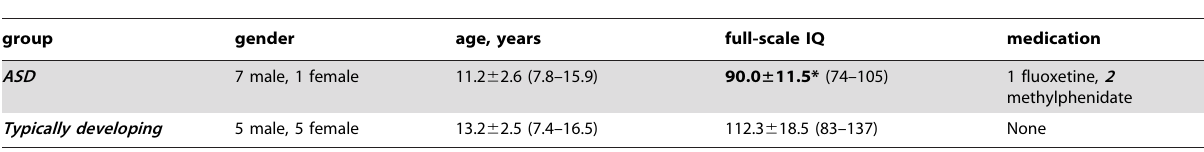
Table 1. Experiment 1: Subject group